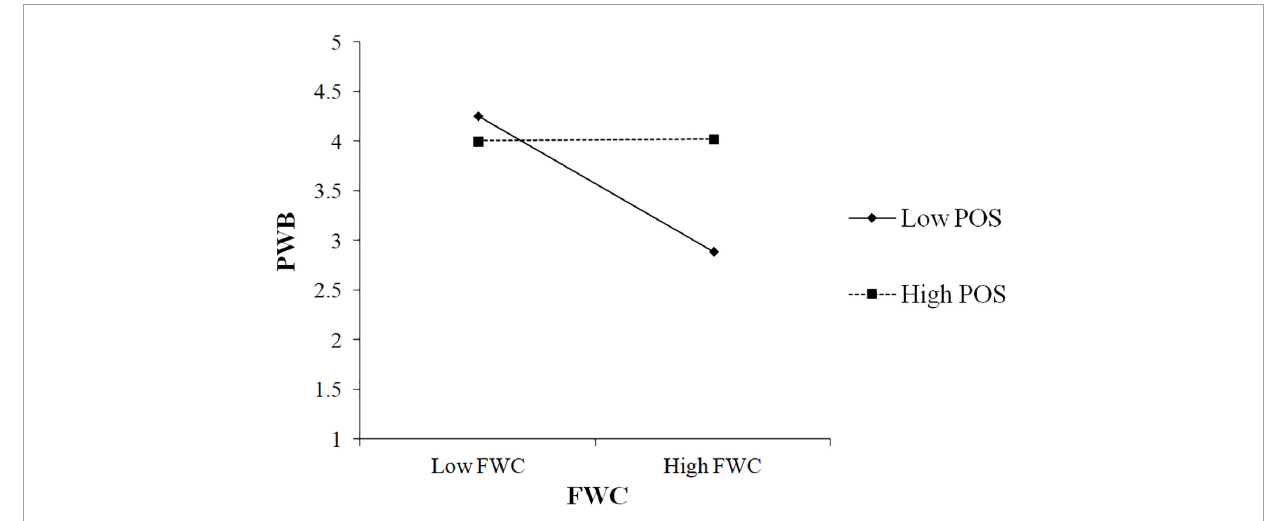
FIGURE3 Effects of family-work conflict (FWC) and POS on PWB.